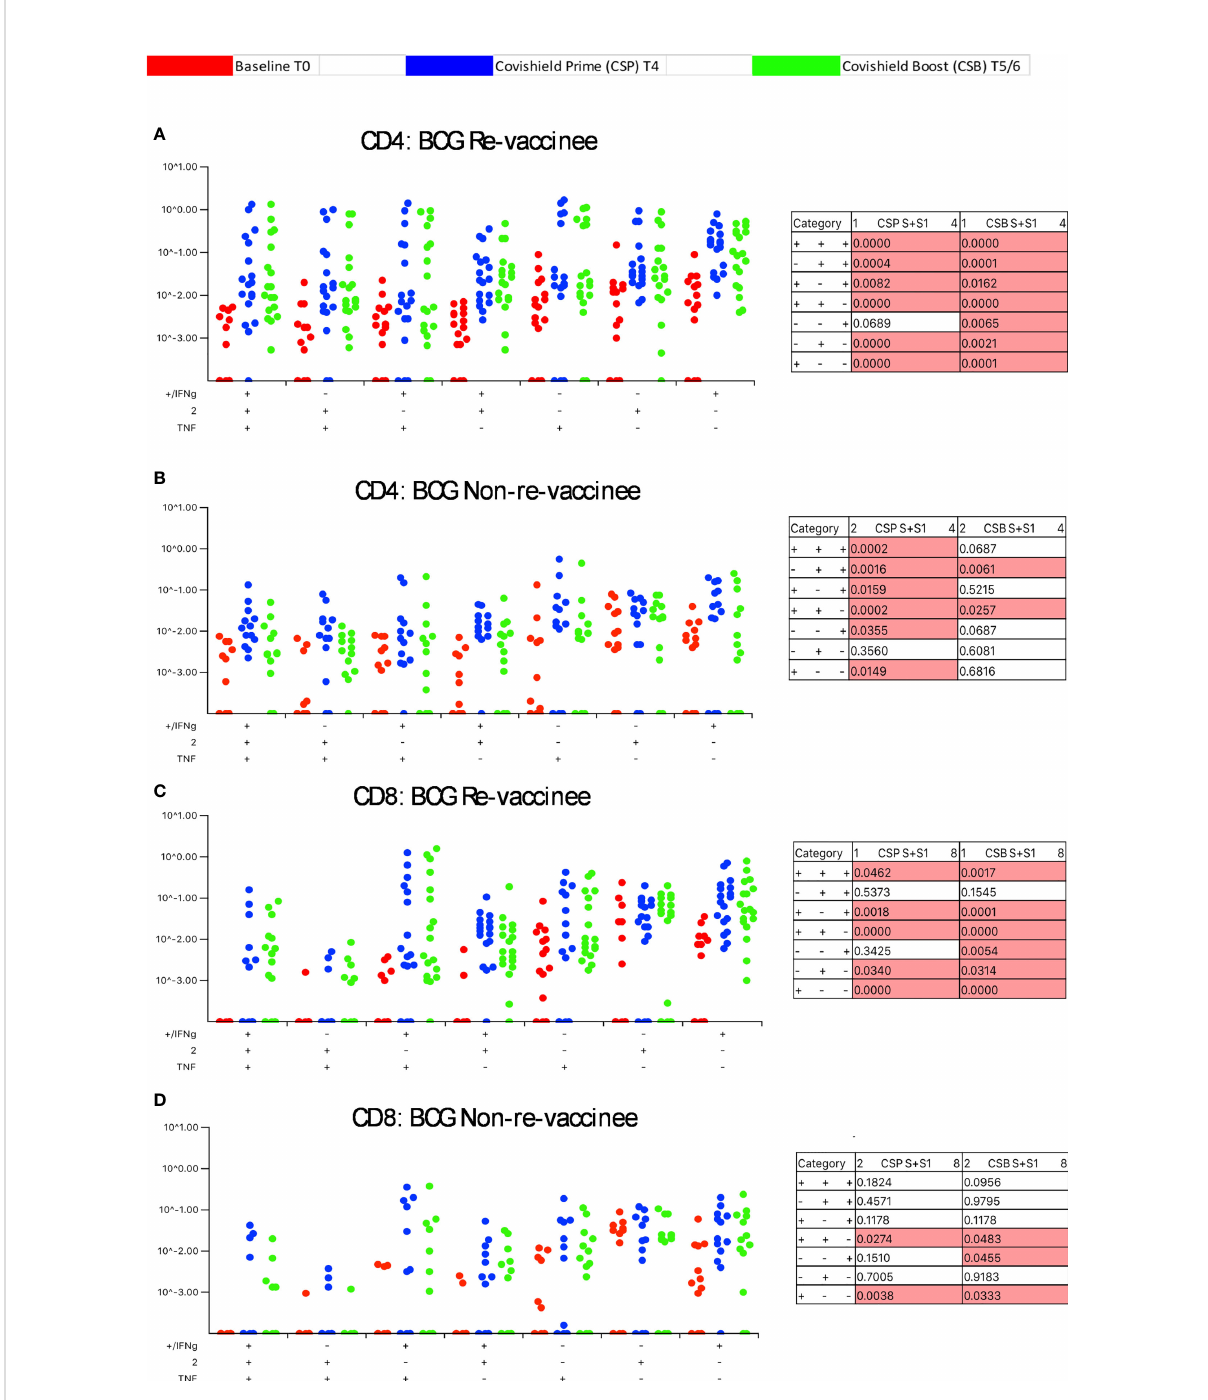
FIGURE 3 BCG revaccination signi fi cantly impacts the quality of the spike-speci fi c CD4+ and CD8+ T cell response in COVISHIELD ™ -vaccinated subjects. Longitudinal multifunctional spike- speci fi c CD4+ T cells (A, B) or CD8+ T cells (C, D) in COVISHIELD ™ vaccinees. PBMCs from individuals collected at baseline (BL, red dots), 2-4 weeks post-prime (CSP, blue dots) and 6-7- or 20-23-weeks post-boost (CSB, green dots) were stimulated with spike for 20hr and CD4+ or CD8+ T cells were analyzed for intracellular expression of IFN- g , IL-2 and TNF- a in a standard ICS assay. Boolean gates were created from the individual cytokines (listed above) in FlowJo to divide responding cells into 7 distinct subsets corresponding to all possible combinations of these functions, and the data were analyzed using SPICE software. Data were analyzed for statistical signi fi cance using Wilcoxon signed-rank test. Background subtracted and log data analyzed in all cases. P < 0.05 was considered statistically signi fi